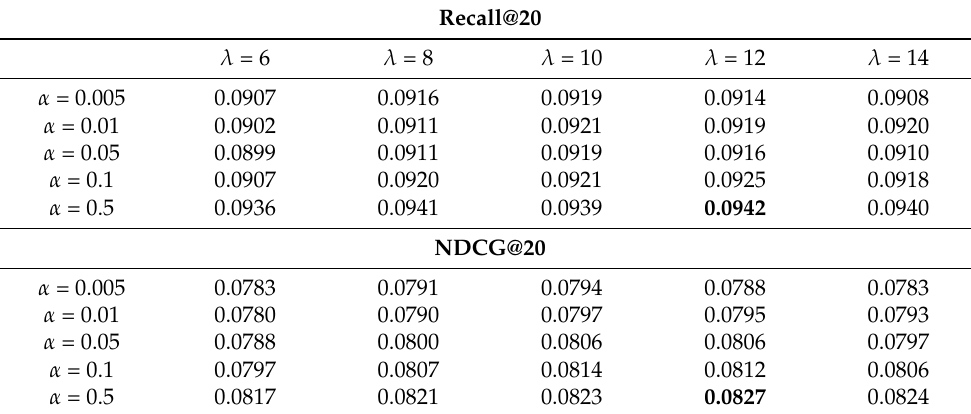
Table 8. Impact of the hyper-parameters α and λ for